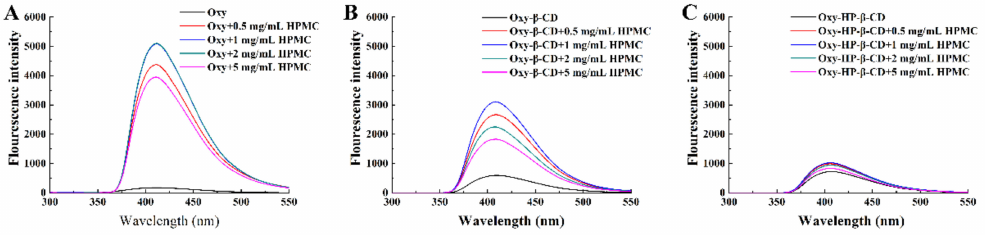
Figure 3. Exemplary fluorescence spectra of Oxy in the presence of various concentrations of HPMC. ( A ) Oxy solution; ( B ) Oxy– β -CD solution; ( C ) Oxy–HP– β -CD